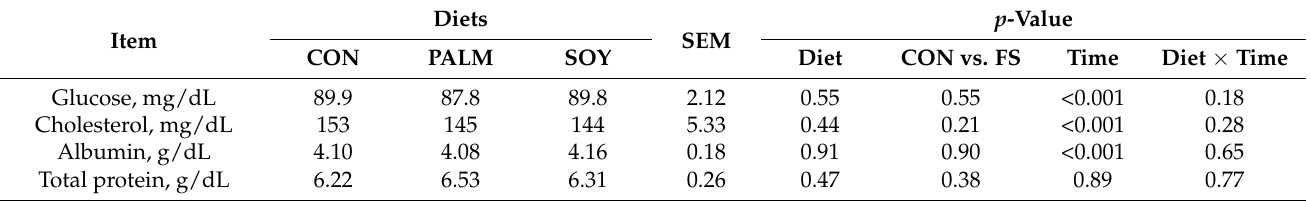
Table 5. Plasma metabolites of lambs fed diets with fat supplements (FS; 50 g/kg) of prilled palm oil (PALM), soybean oil (SOY), or without fat supplementation